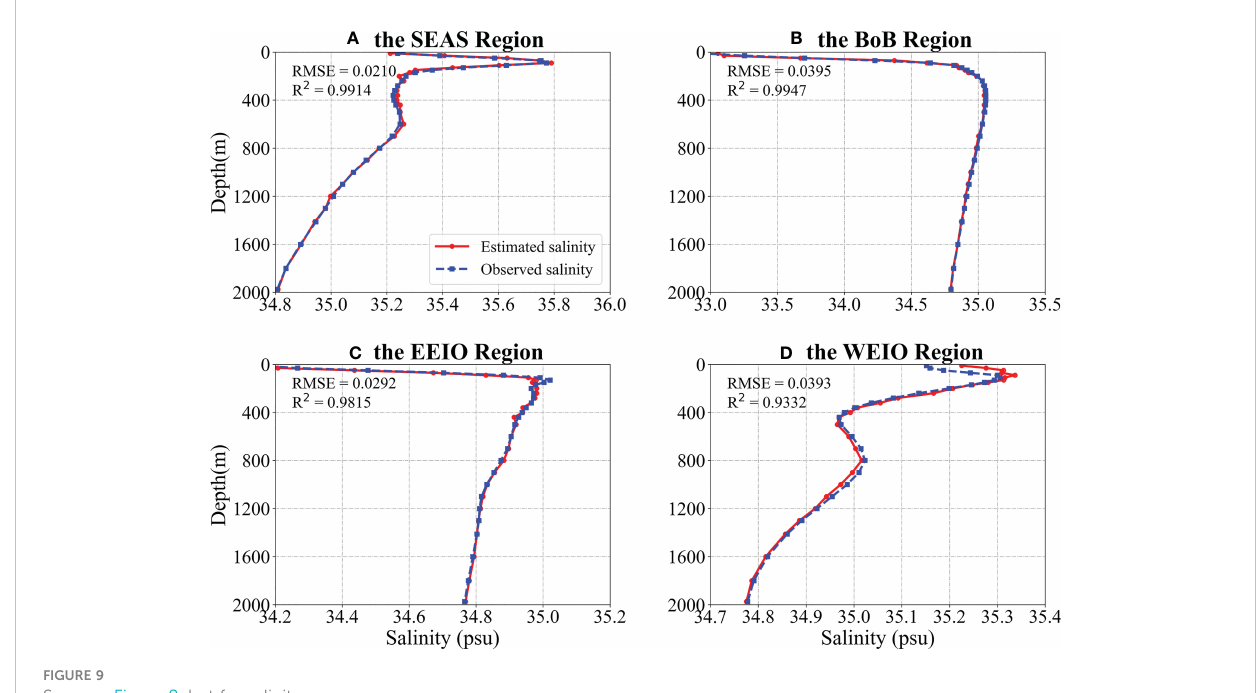
FIGURE 9 Same as Figure 8, but for salinity.